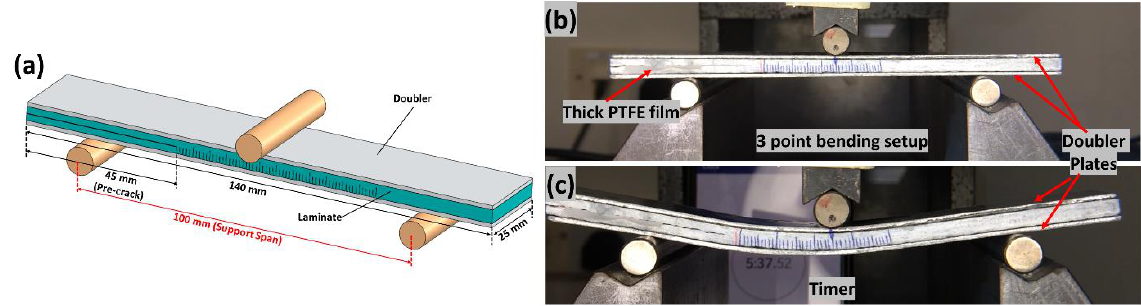
Figure 5 . ( a ) Schematic of the Mode II tests sample with dimensions ( b ) Mode II test setup and ( c ) Specimen undergoing Mode II test.